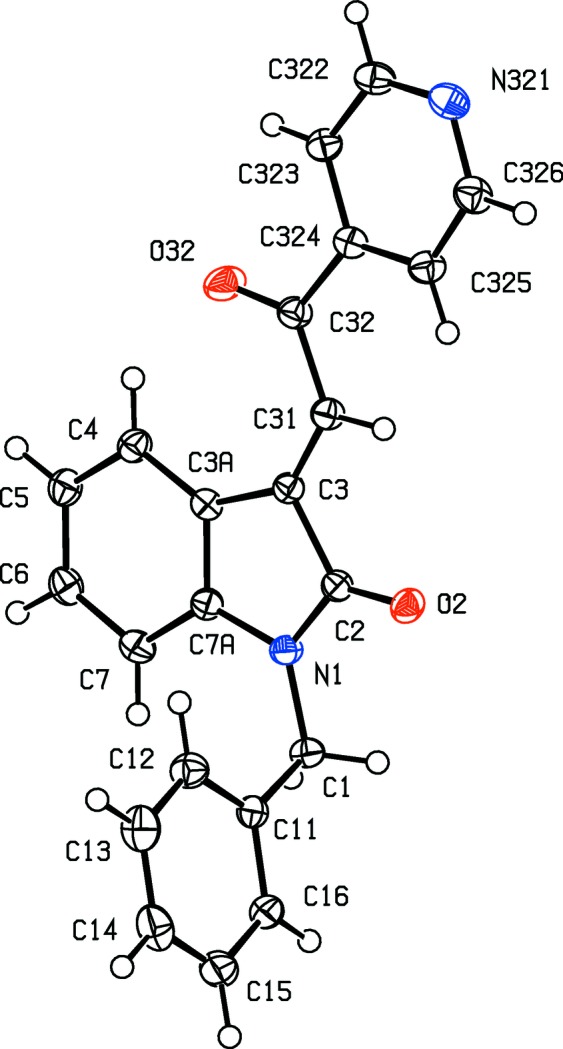
The mol­ecular structure of com­pound (IIe), showing the atom-labelling scheme. Displacement ellipsoids are drawn at the 30% probability level.